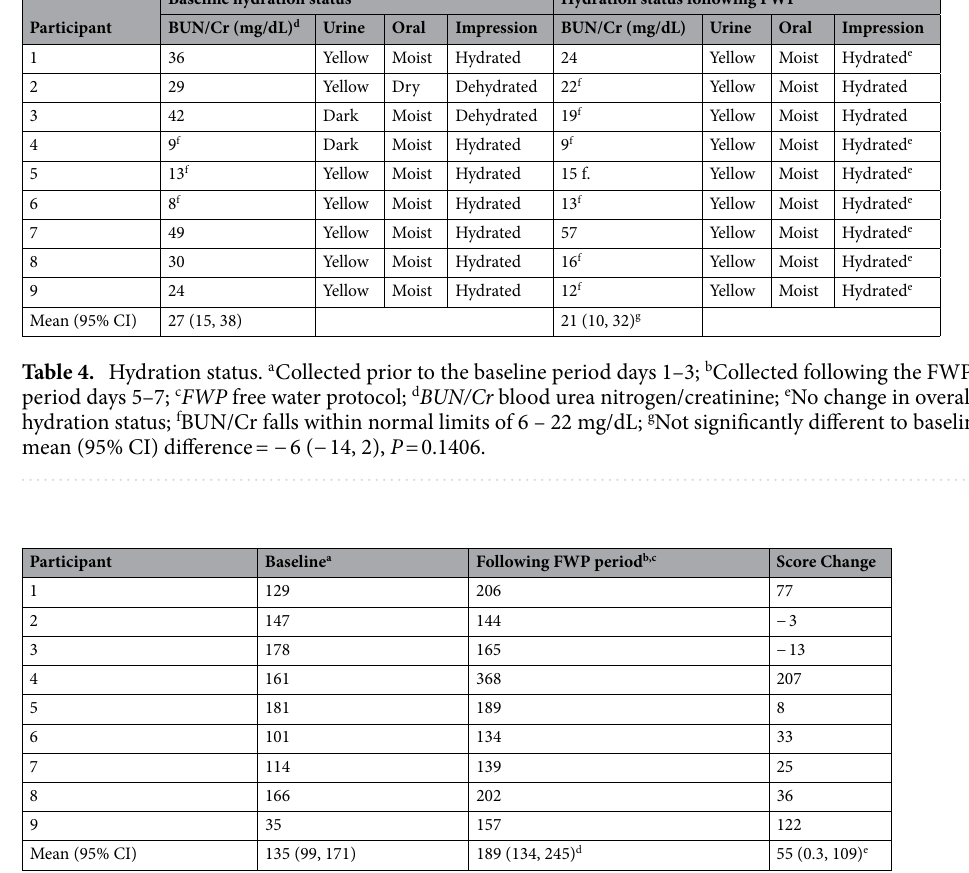
Table 5. Swallowing quality of life (SWAL-QoL). a Collected prior to the days 1–3 baseline collection period; b Collected following the days 5–7 FWP period; c FWP: free water protocol; d Significantly different compared to baseline using Wilcoxon matched pairs test; P = 0.0273; e Differences in rounding may give the appearance of math